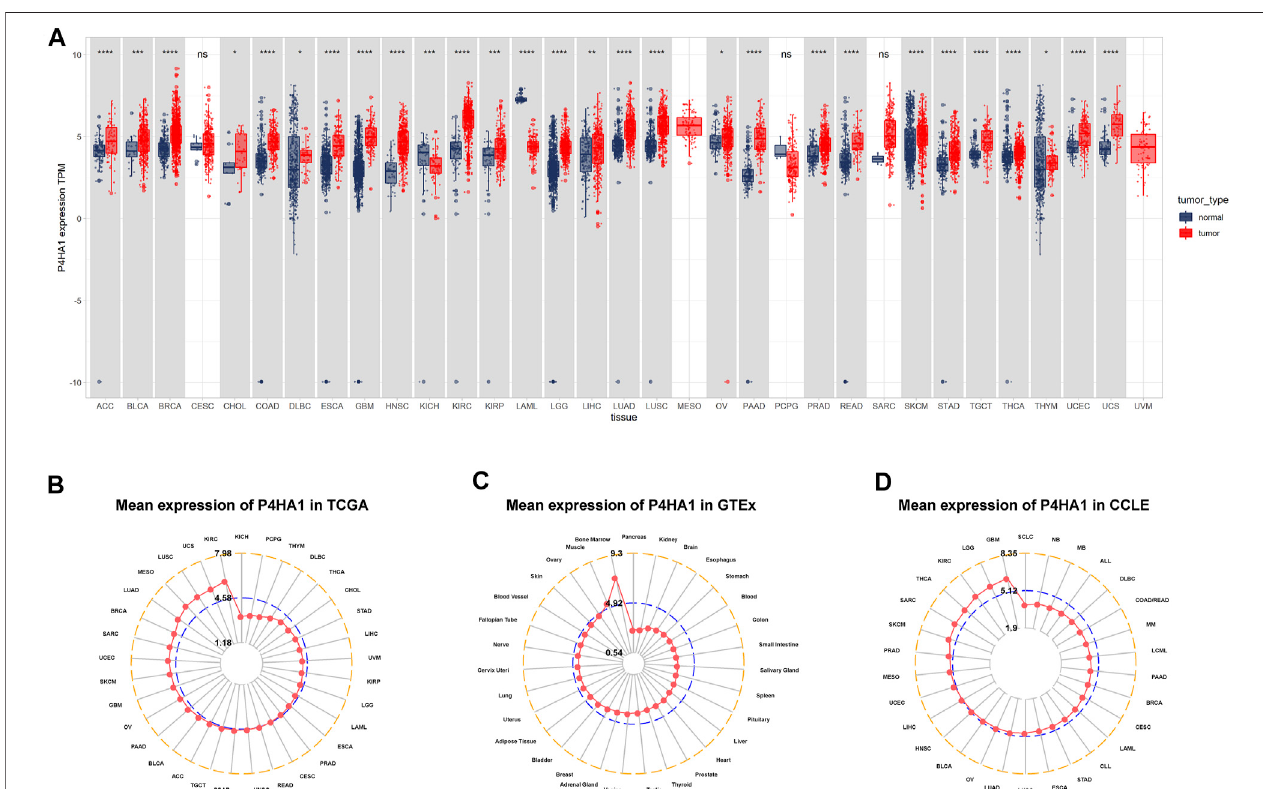
FIGURE 1 | Expression of P4HA1 in pan-cancer. (A) pan-cancer expression of P4HA1. (B) P4HA1 expression in tumor tissues from TCGA cohort. (C) P4HA1 expression in normal tissues from GTEx cohort. (D) P4HA1 expression in cancer cell lines from CCLE cohort. * p < 0.05, ** p < 0.01, *** p < 0.001, **** p < 0.0001.